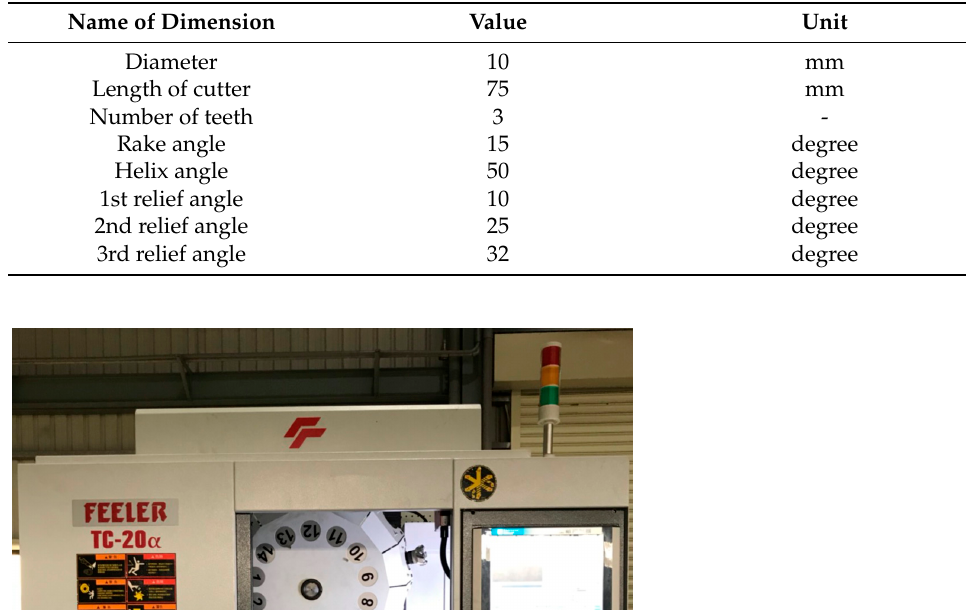
Table 2. Basic dimensions of the cutting tool.